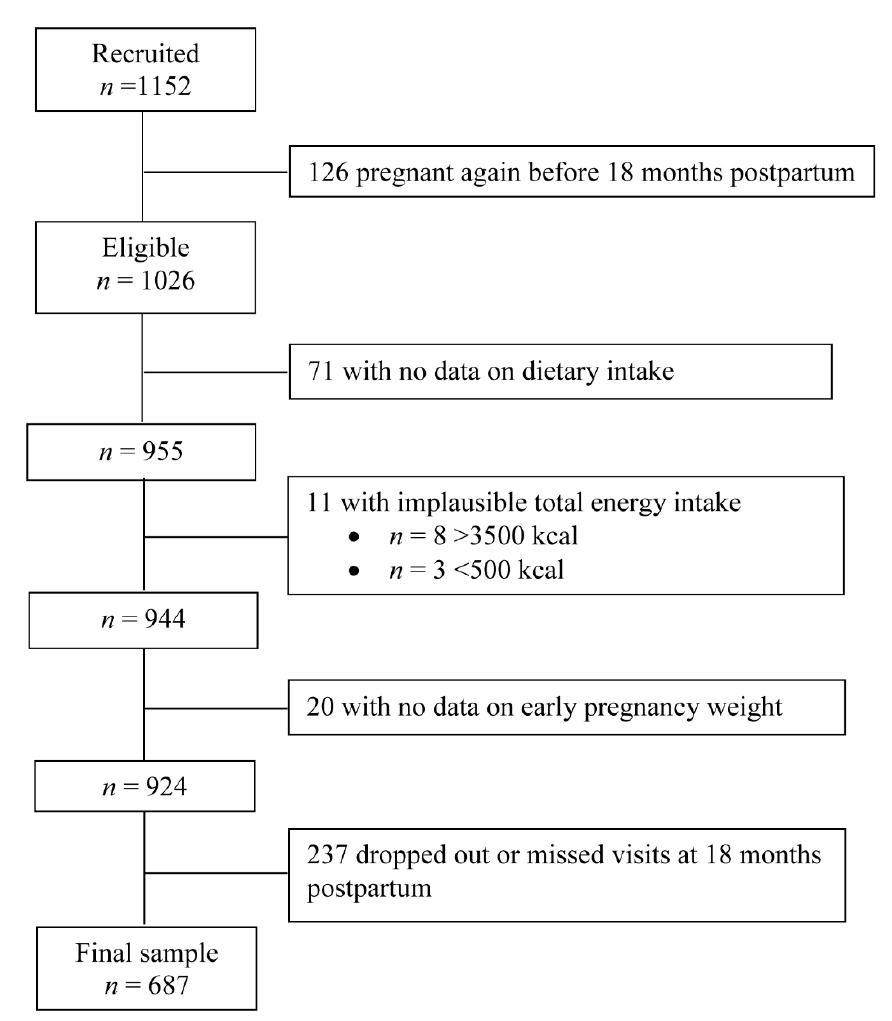
Figure 1. Flowchart of women included for analysis in the Growing Up in Singapore Towards healthy Outcomes (GUSTO) study, Singapore.